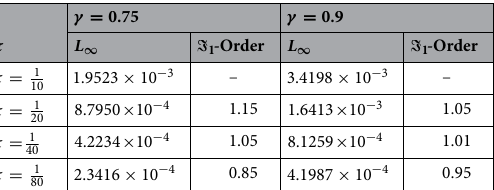
Table 9. Temporal variable convergence order for the Example 1, when h = 1 8 .